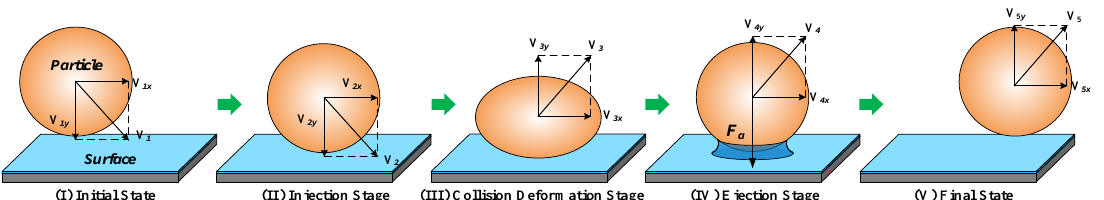
Figure 3. Sketch diagram of collision process between particle and surface.